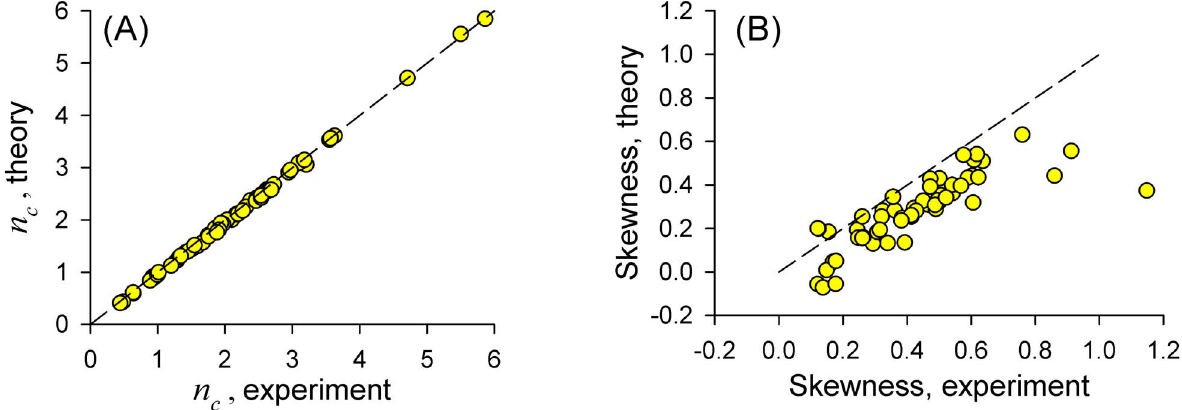
Figure 8. Comparison of experimental data with theory for the sample of n ~ 56 paddlefish ERs. A : ISI correlation lags n c calculated from the experimental data according to Eq.(14), vs. values from theory, Eq.(15), calculated using parameters obtained from fitting experimental SCCs. B : Skewness of experimental vs. theoretical ISI distributions. 45 u line is shown by dashed strokes on both panels. doi:10.1371/journal.pcbi.1003170.g008 PLOS Computational Biology |